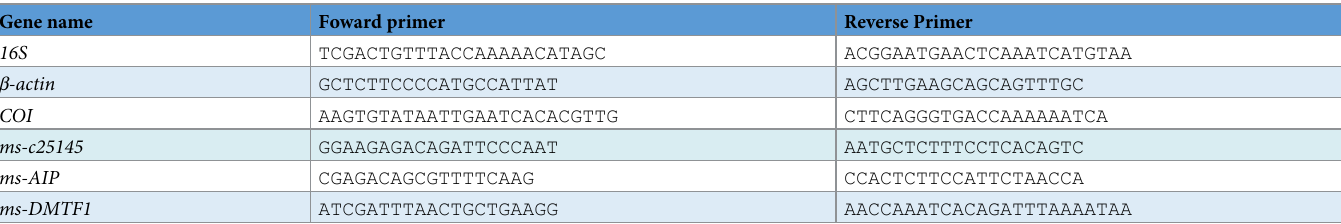
Table 1. Sequences of the primers used in this